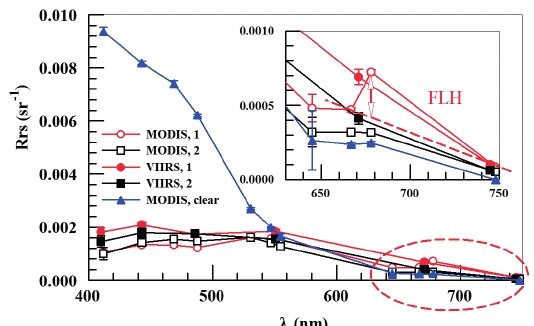
Figure 5. Rrs spectra from three locations of the NEGOM region (locations shown in Figure 3). Location 1 is in the high-nFLH bloom (circles) and Location 2 is in the nearby low-nFLH water (squares). For reference, MODIS Rrs from a clear-water location (annotated as a star in Figure 3a) is also shown. The spectra in the red and NIR are enlarged in the inset figure, where the calculation of nFLH for Location 1 is illustrated with a double-headed arrow. The standard error bars were derived from 3 × 3 1-km pixels centered at the locations. Note that although cross-sensor difference is relatively large for the blue bands, cross-location difference for the same sensor is much